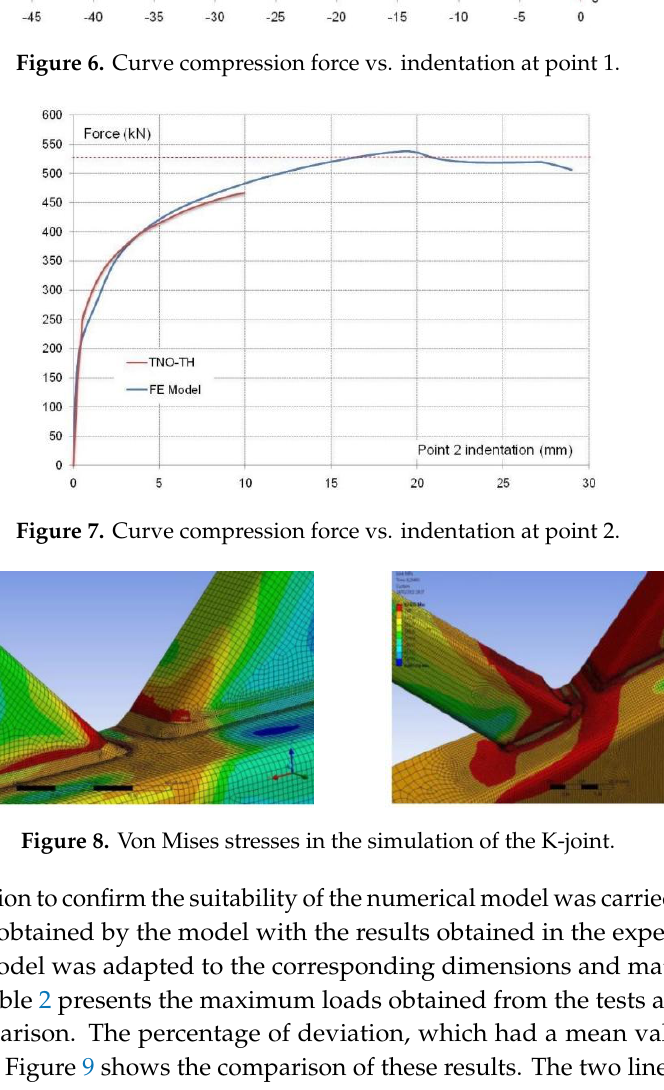
Table 2. Maximum load from tests and simulation.